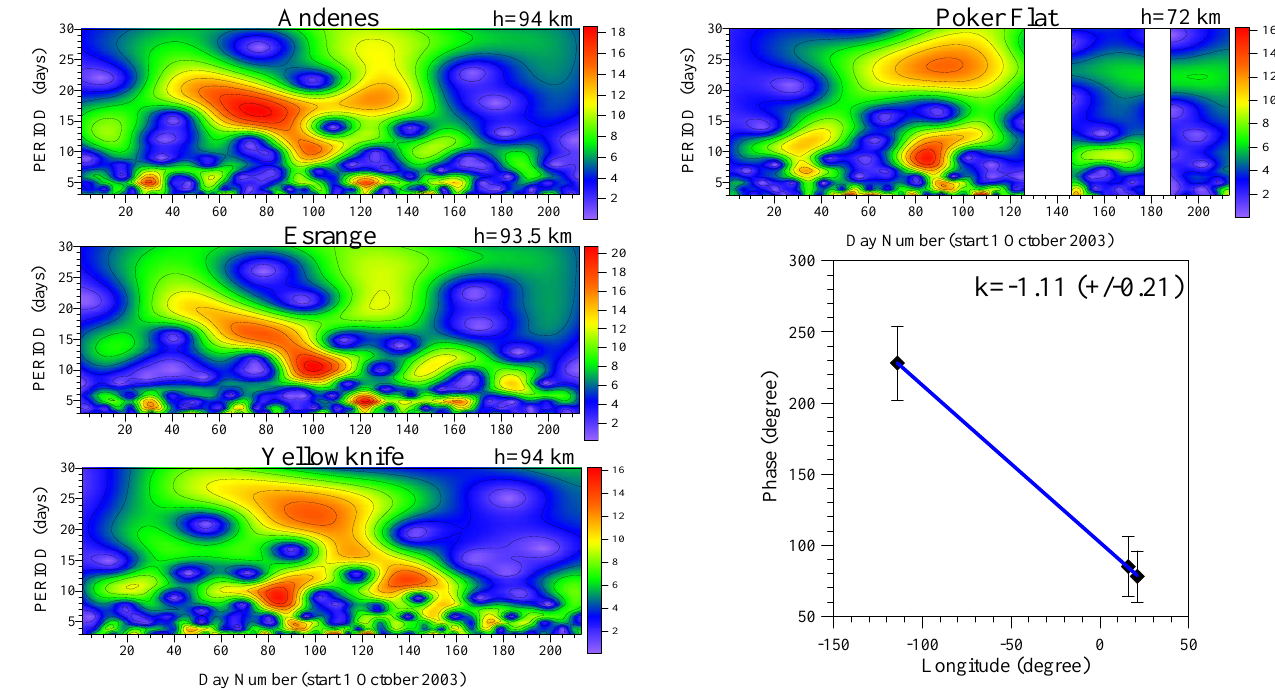
Figure 14 Fig. 14. Wavelet spectra calculated in the period range from 3 to 30 days for the zonal wind at 94km height measured at high-latitude stations Esrange, Andenes and Yellowknife (left column of plots), while the upper right plot shows the wavelet spectra calculated for zonal wind at 72km height measured at Poker